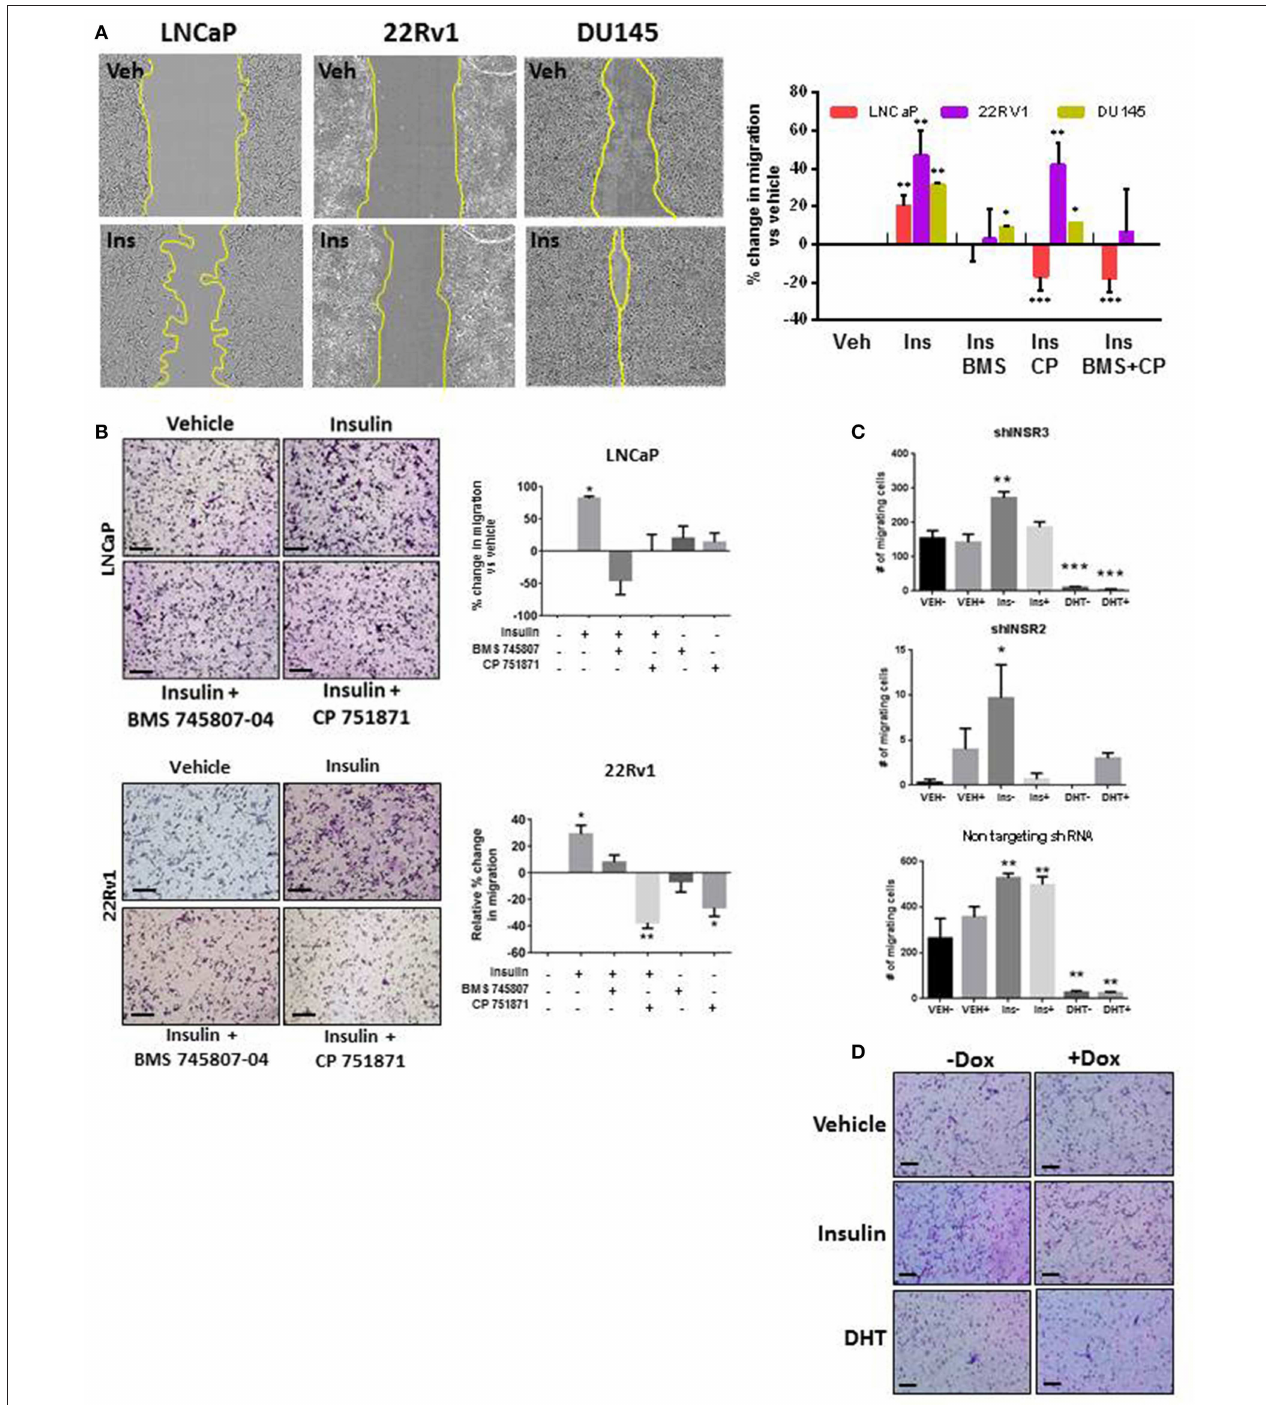
FIGURE 1 | Insulin induced migration in PCa cells is reduced with IR/IGF-1R inhibition. (A) Insulin (10nM) accelerated wound closure in LNCaP, 22RV1, and DU145 cells. Images show wound closure following 24h insulin treatment, quantitated in the histogram (relative to vehicle). Migration was reduced by the BMS 745807 (10 uM). CP 751871 (5 ug/ml) reduced insulin-induced migration in LNCaP and DU145 cells, but not significantly in 22RV1 cells. (B) Insulin also increased transwell migration which was reduced in the presence of BMS 745807 and CP 751871 in LNCaP and 22RV1cells. (C,D) LNCaP cells expressing dox-inducible shINSR or a non-targeting shRNA were induced ( + ) and compared to no dox added (–). The loss of IR expression reduced the number of migrating cells following insulin treatment in shINSR cells but not in non-targeting cells. Ten nanomolar DHT also suppressed cell migration. All scale bars = 100 µ m (all graphs n = 3, * p < 0.05, ** p < 0.01, *** p < 0.001, One-way ANOVA, ± SEM with vehicle control).